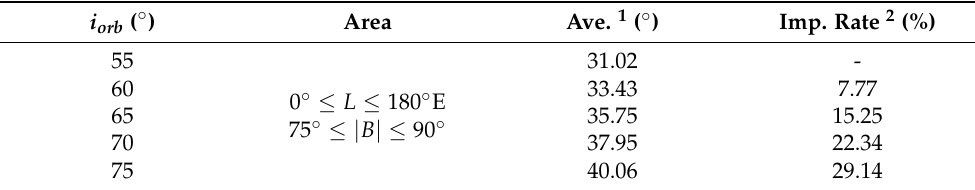
Table 2. Statistical results of the average elevation angles of IGSO satellites with different